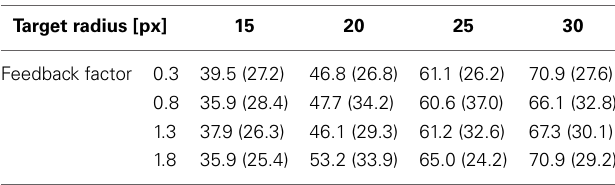
Table 2 | Mean hit rates [%] relating to the visible target surface in Experiment